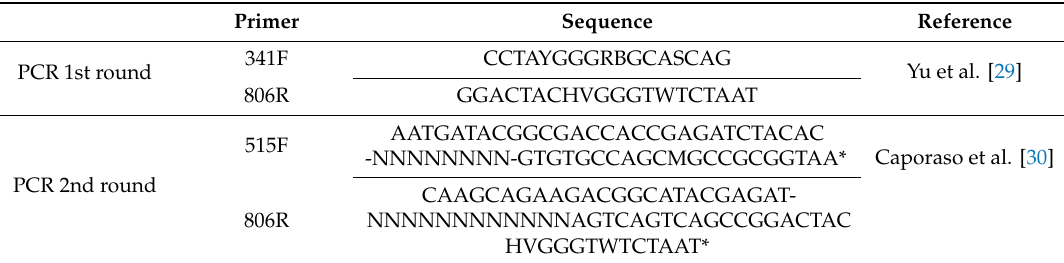
Table 1. Primers used for the PCR-based library